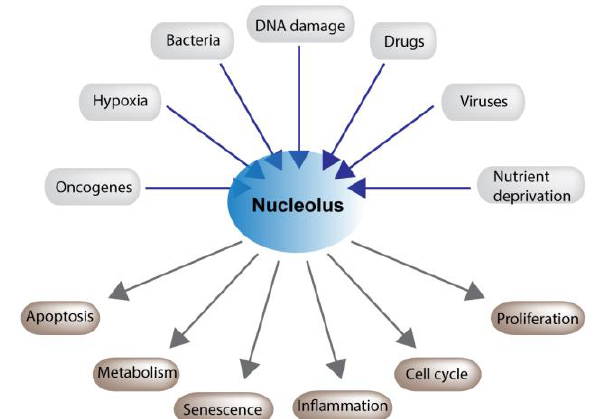
Figure 2. Nucleoli play a critical role in maintaining cellular homeostasis. Nucleolar function is altered in response to a plethora of cytotoxic and environmental stresses. This disruption modulates an array of cellular processes which allow cells to recover or, if the damage is to great, to undergo cell death.